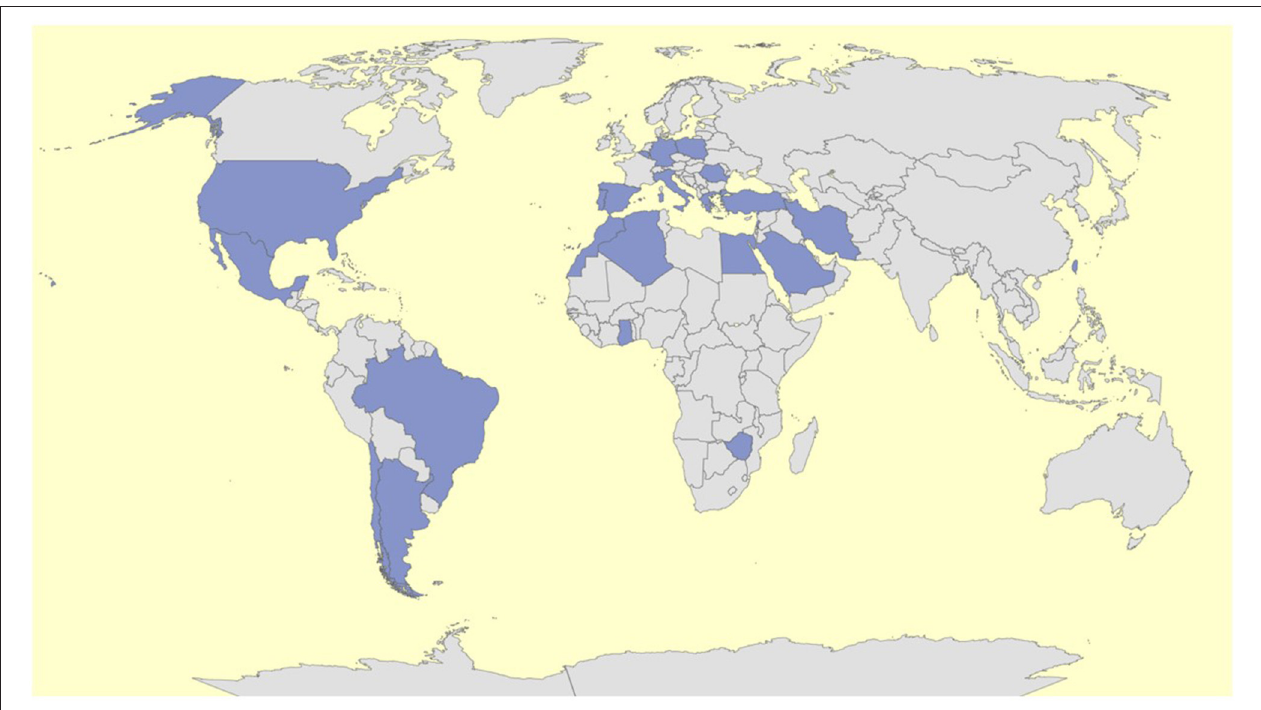
FIGURE 1 | Worldwide distribution of the AIDA network on 22 nd of April